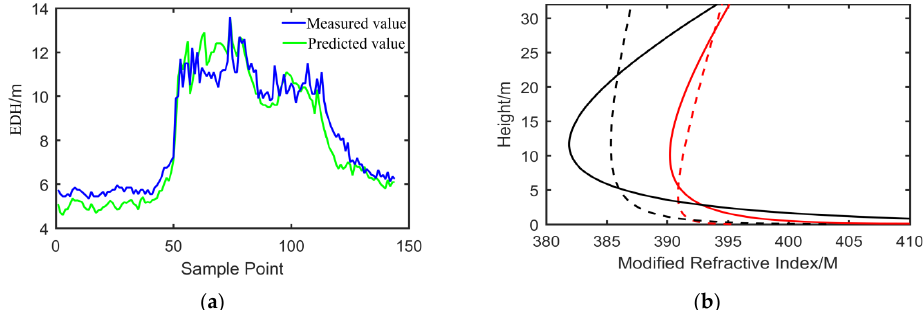
Figure 13. ( a ) The measured and predicted EDH from 0:00 to 23:59 in a day. The EDH was measured directly according to the Debye theory and also predicted on the basis of the NAF model with respect to the blue solid line and green solid line, separately. ( b ) Modified refractive index profile as the function of the height at two different moments with respect to the black line and red line, separately. The solid line represents the measured profile according the Debye theory, and the broken line expresses the predicted profile on the basis of the NAF model.